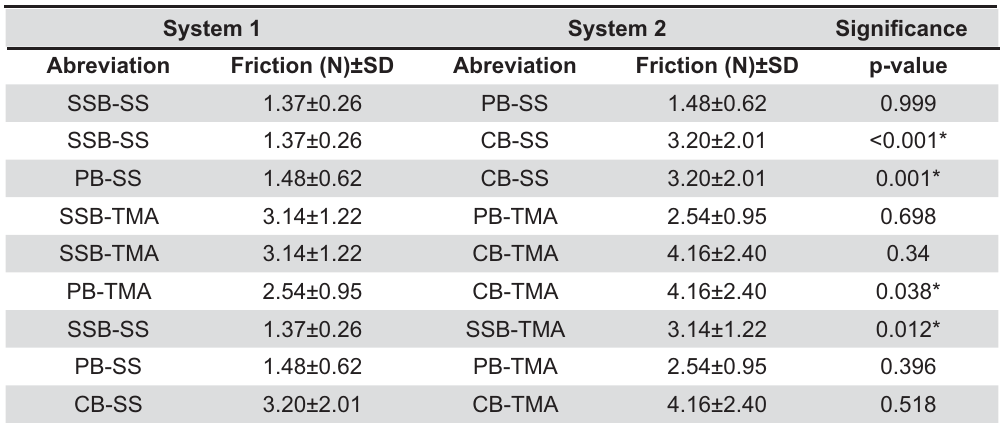
Table 2- (cid:2)(cid:3)(cid:4)(cid:5)(cid:4)(cid:6)(cid:7)(cid:4)(cid:6)(cid:8)(cid:5)(cid:9)(cid:2)(cid:10)(cid:5)(cid:4)(cid:5)(cid:2)(cid:11)(cid:12)(cid:2)(cid:13)(cid:14)(cid:6)(cid:8)(cid:4)(cid:6)(cid:11)(cid:12)(cid:2)(cid:8)(cid:11)(cid:15)(cid:13)(cid:16)(cid:8)(cid:6)(cid:15)(cid:12)(cid:4)(cid:2)(cid:11)(cid:13)(cid:2)(cid:4)(cid:17)(cid:15)(cid:2)(cid:7)(cid:18)(cid:7)(cid:4)(cid:15)(cid:19)(cid:7)(cid:2)(cid:11)(cid:13)(cid:2)(cid:20)(cid:14)(cid:5)(cid:8)(cid:21)(cid:15)(cid:4)(cid:2)(cid:5)(cid:12)(cid:10)(cid:2)(cid:22)(cid:6)(cid:14)(cid:15)(cid:2)(cid:23)(cid:12)(cid:24)(cid:25)(cid:26)(cid:27)